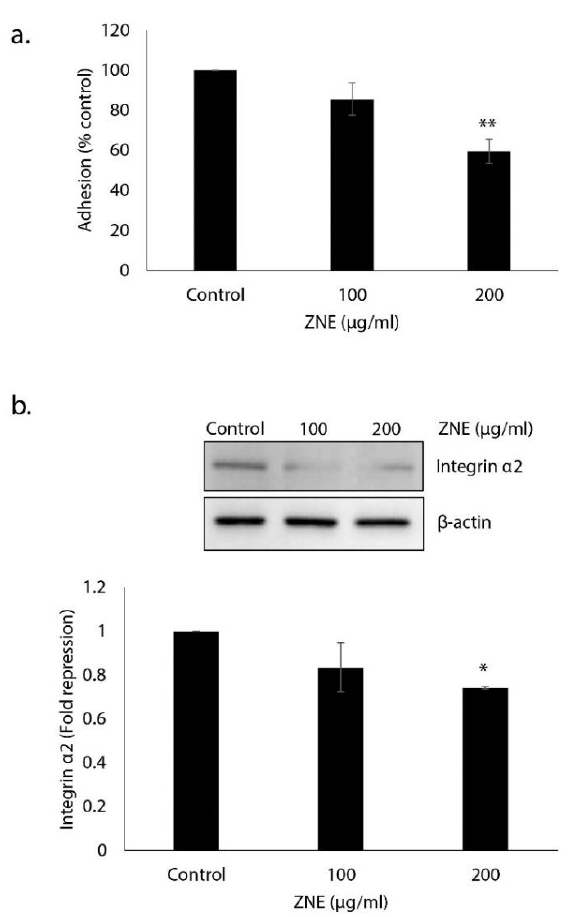
Figure 6. Ziziphus nummularia inhibits the adhesion of Capan-2 cells to collagen and downregu- lates α 2 integrin. ( a ) Capan-2 cells were treated overnight with or without the indicated concen- trations of ZNE and then seeded onto collagen-coated wells and allowed to adhere for 10 min as described under Materials and Methods. Adhesion was assessed by MTT assay and determined as a percentage of the corresponding vehicle-treated control value. Data represent the mean ± SEM ( n = 3 replicates) from three independent experiments. ** denotes p < 0.01. ( b ) Capan-2 cells were incubated for 48 h with or without the indicated concentrations of ZNE, and whole cell extracts were subjected to Western blotting analysis for integrin α 2 expression using β-actin as loading control. Data represent the mean ± SEM from three independent experiments. * denotes p < 0.05.